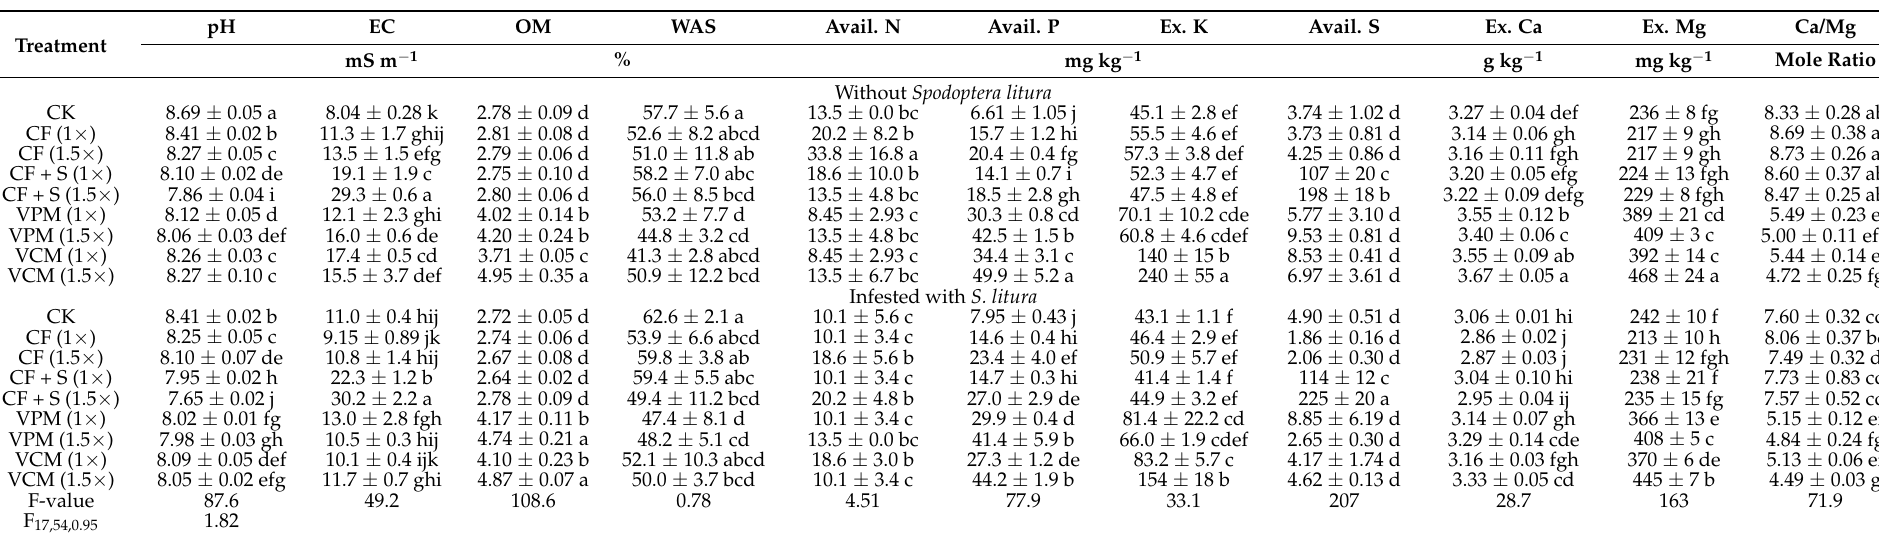
Table 2. The soil properties 1 after the pot experiment, in which soil was subjected to different treatments 2 .